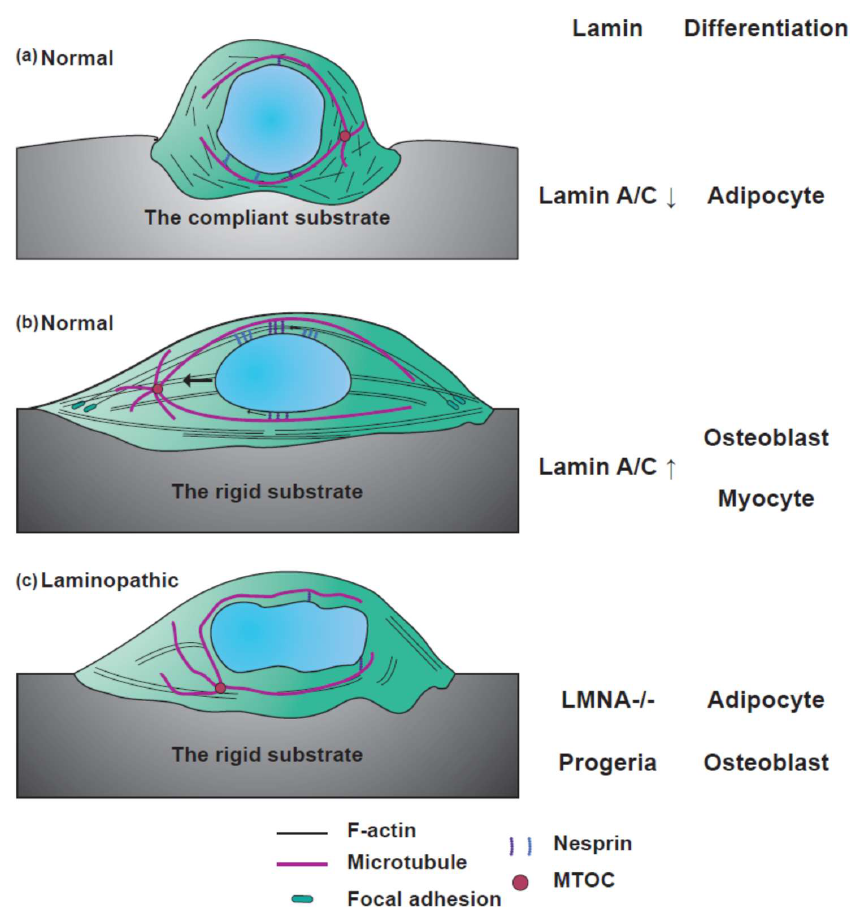
Figure 3. Mechanosensation and differentiation determined by lamin and the substrate stiffness. Cells on hydrogels of different stiffnesses show distinct mechanosensation. Substrate stiffness-dependent stem cell differentiation depends on different lamin A/C expression. ( a ) A cell on the compliant substrate is less spread out, and cytoskeleton formation and nuclear shape maintenance are inhibited by the compliant substrate. On the compliant substrate, lamin A/C expression decreases and the stem cell can differentiate into an adipocyte. ( b ) A normal cell on the rigid substrate is fully spread out with well-organized F-actin and microtubules. Focal adhesions on the rigid substrate are also bigger than on the soft substrate. Lamin A/C expression increases as the substrate stiffness increases. Therefore, stem cells with a rigid nucleus can differentiate into osteoblasts and myocytes. ( c ) Laminopathic cells featuring fragile nuclei show miniscule focal adhesions, even when laminopathic cells are on the rigid substrate. Laminopathic cells display attenuated mechanotransduction due to weak nucleus–cytoskeletal